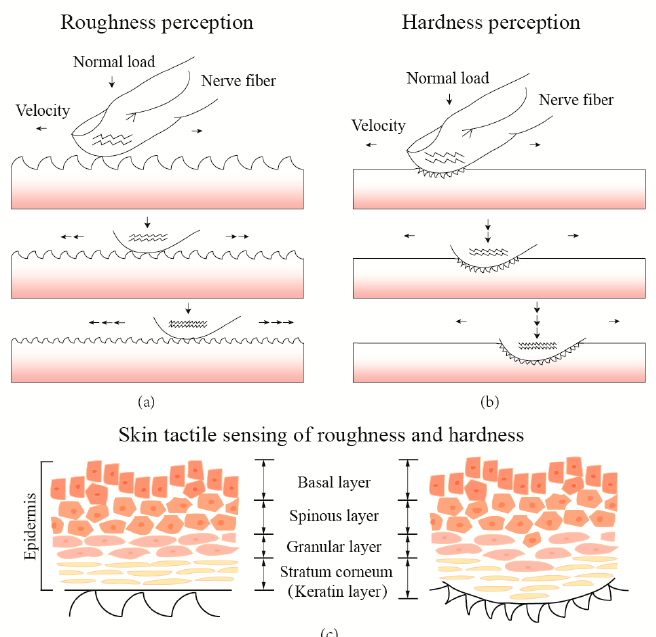
Figure 1. ( a ) Schematic illustrating roughness tactile perception based on the skin vibration as a function of sliding velocity during a fingertip rubbing on different textured surfaces; ( b ) hardness tactile perception as a function of normal load on various hardness materials; and ( c ) the structure of skin epidermis and its deformation in both two tactile perceptions.